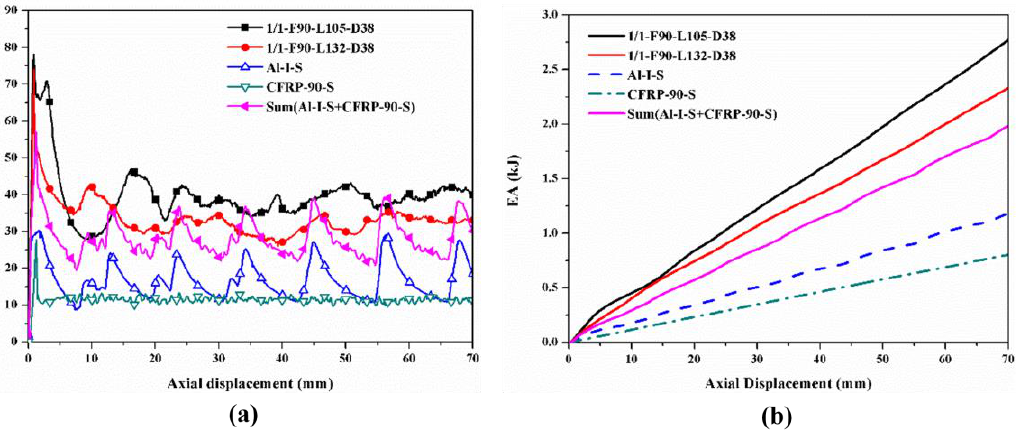
Figure 16. Hybrid effect of 1/1 hybrid tube with nominal outer diameter of 38 mm: ( a ) axial load – displacement curves; ( b ) EA – displacement curves.